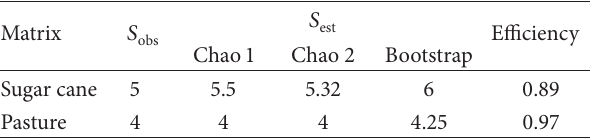
Table2:Observedspeciesrichness( 𝑆 ) for three estimators and efficiency ( 𝑆 ( 𝑆 est terrestrial amphibians in the fragments of Semi-deciduous seasonal forest with two predominant matrix types (sugar cane and